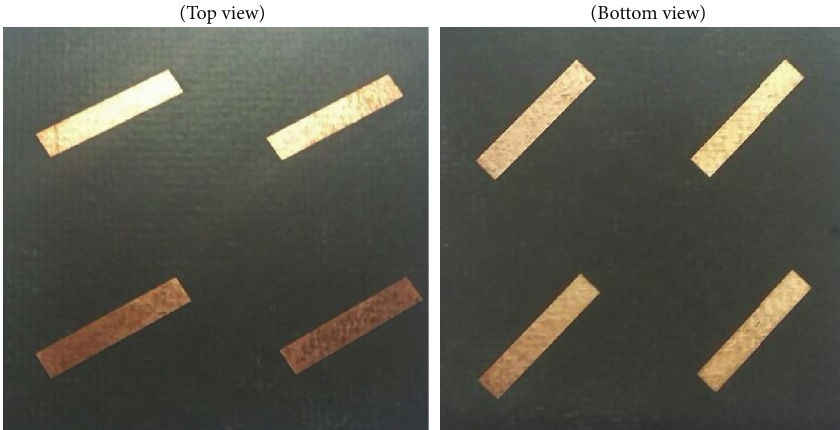
Figure 5: The figure shows the photographs of the fabricated